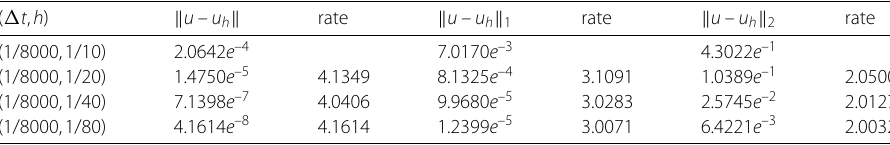
Table 1 The errors for different space step h at t = 1 and convergence orders